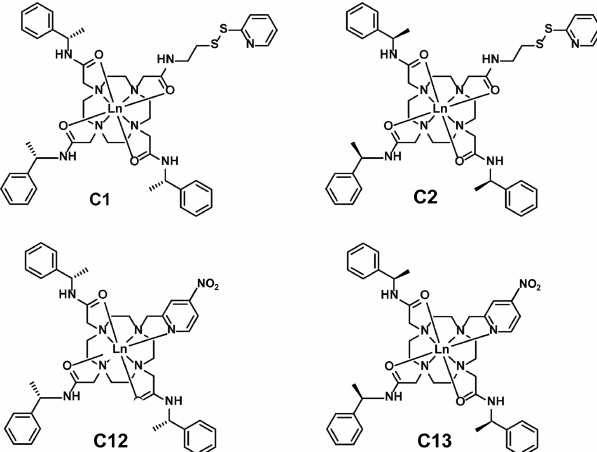
Figure 5. Chemical structures of the lanthanoid tags used in the present work. Compared to the C1 and C12 tags, the C2 and C13 tags have the opposite chirality in each of the phenylethylamide pendants. The C1 and C2 tags react with cysteine thiol groups with the formation of a disulfide bond (Graham et al., 2011), whereas the C12 and C13 tags produce a thioether bond by nucleophilic substi- tution of the nitro group (Herath et al.,